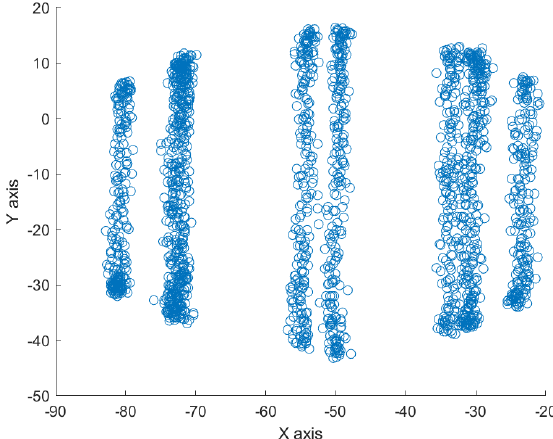
Figure 5. X − Y plane distribution of initial measurement data.